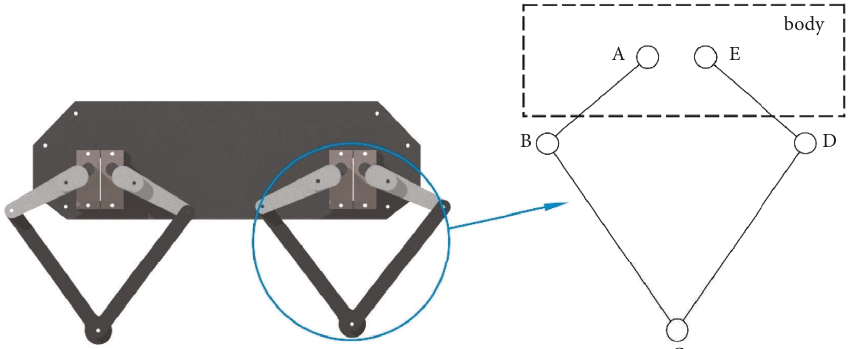
Figure 2: The 2-DOF parallel leg mechanism.